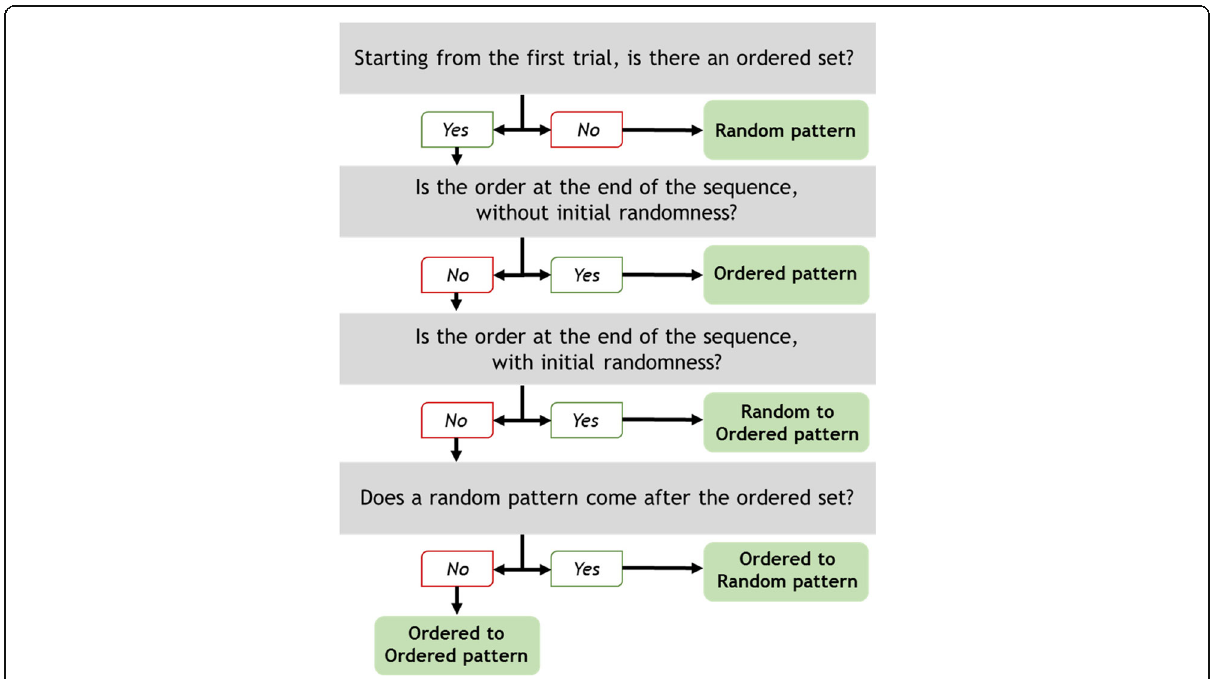
Fig. 8 Decision tree to categorize patterns of performance in Experiment